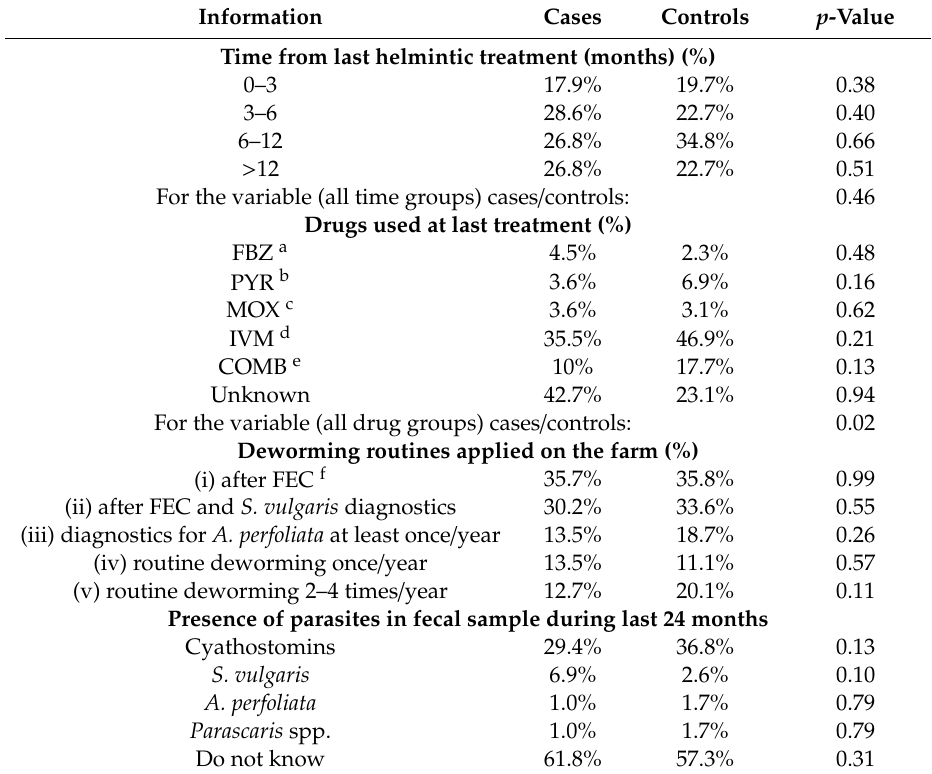
Table 4. Result of questionnaire data: anthelmintic routines. The p -value for statistical significance was corrected for the number of analyses (n = 4) according to Bonferroni, i.e., p < 0.01 (0.05 / 4). Information Cases Controls p